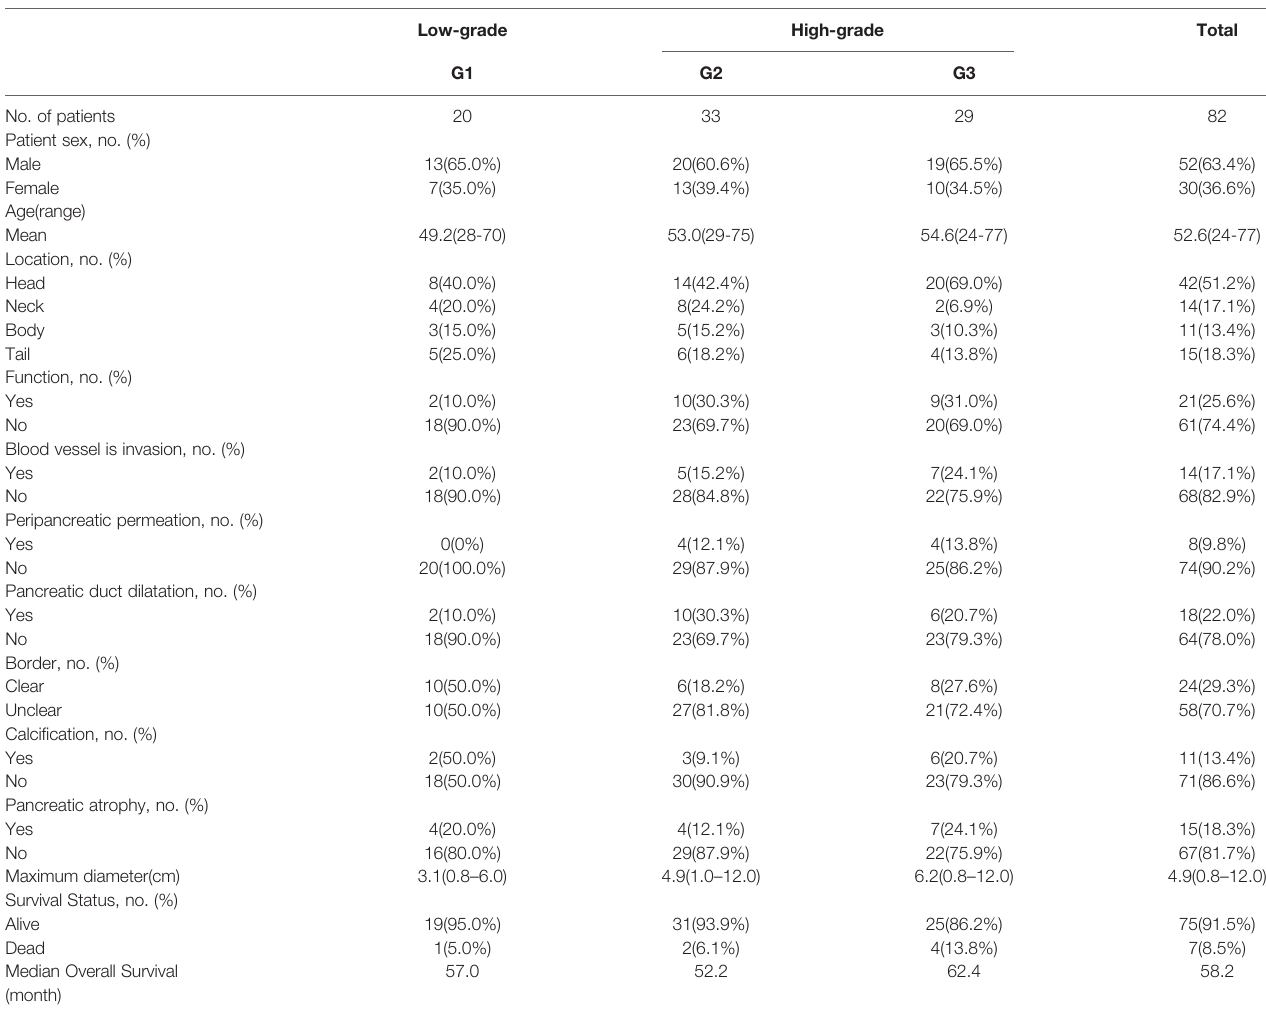
TABLE 1 | Characteristics of patients and